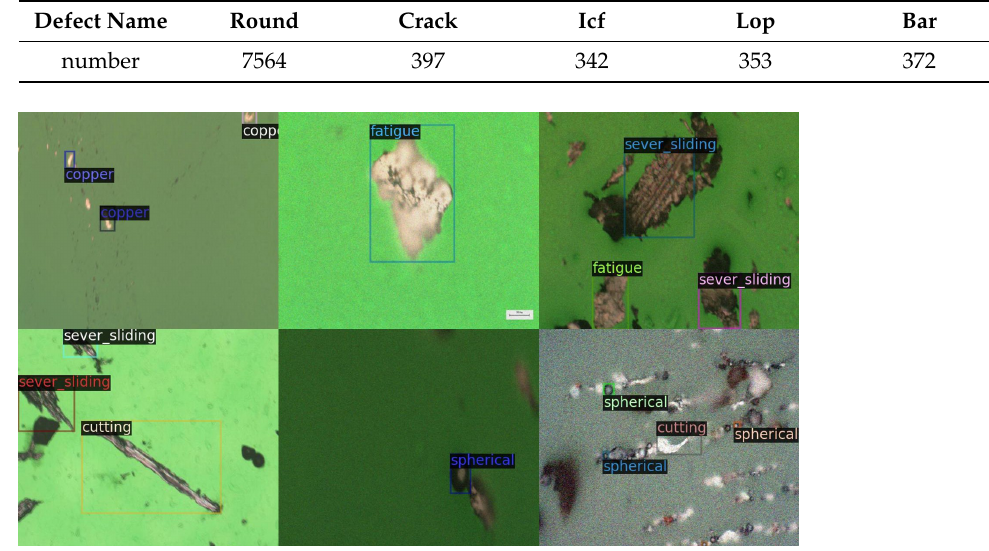
Figure 7. Wear debris defect dataset. Table 2. The number of each category in wear debris defect